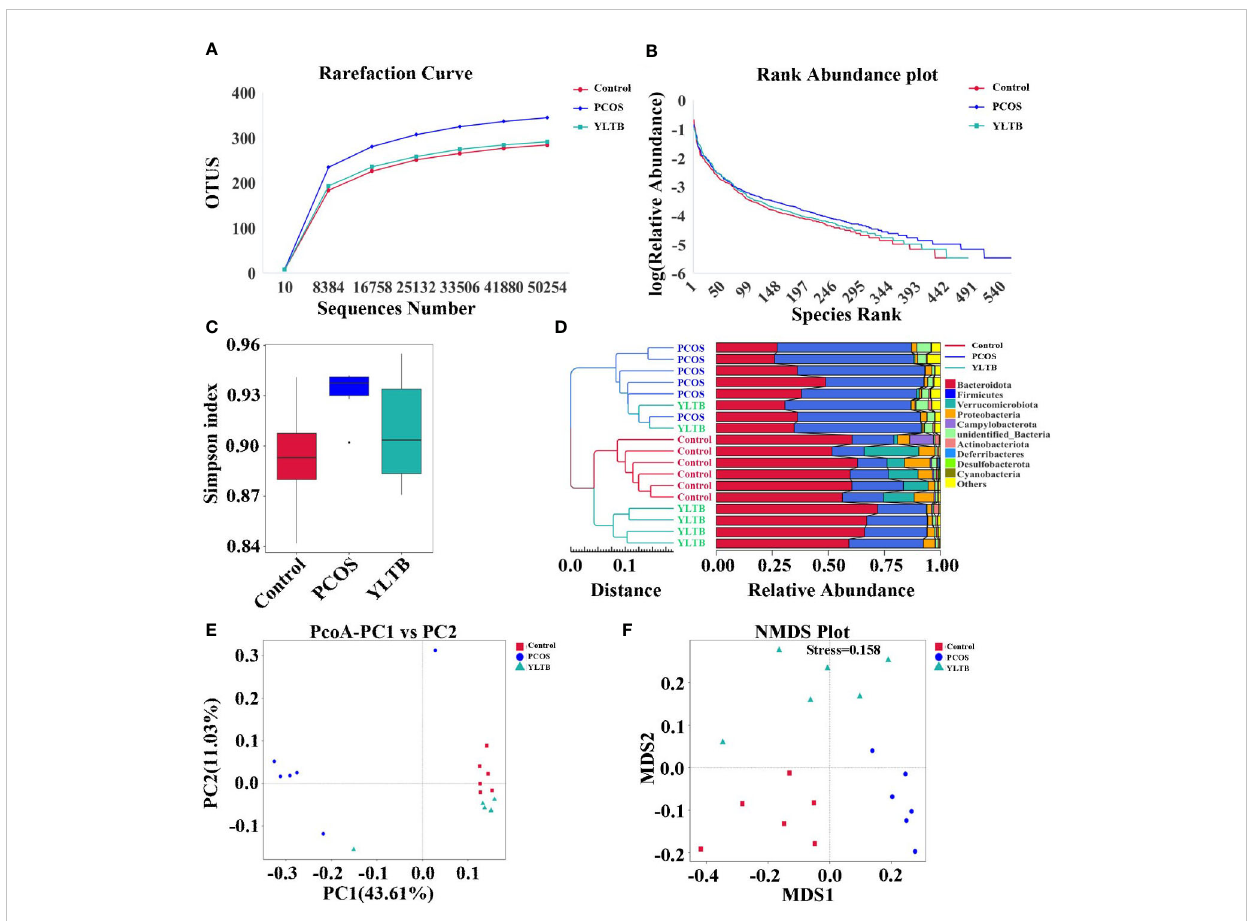
FIGURE 4 Effect of YLTB on a and b diversity of gut microbiota. (A, B) Analysis of gut microbial diversity was performed on the basis of 16S rRNA sequencing and was presented by rarefaction curves and rank abundance curves. (C) The a -diversity of gut bacterial assemblages with Simpson index in the mice receiving different treatments. (D) Evaluation of b -diversity with bacterial community compositional similarity using UPGMA cluster analysis, and the clustering result and the relative abundance of each sample at the phylum level were displayed. The left side is the UPGMA clustering tree structure, and the right side is the relative abundance distribution map of each sample at the phylum level. (E, F) Plots of unweighted UniFrac-based PCoA and nonmetric multidimensional scaling (NMDS) based on Bray-Curtis distance. Each point in the graph represents a sample, the distance between points indicates the degree of variation, and the samples of the same group are represented by the same color. n = 6